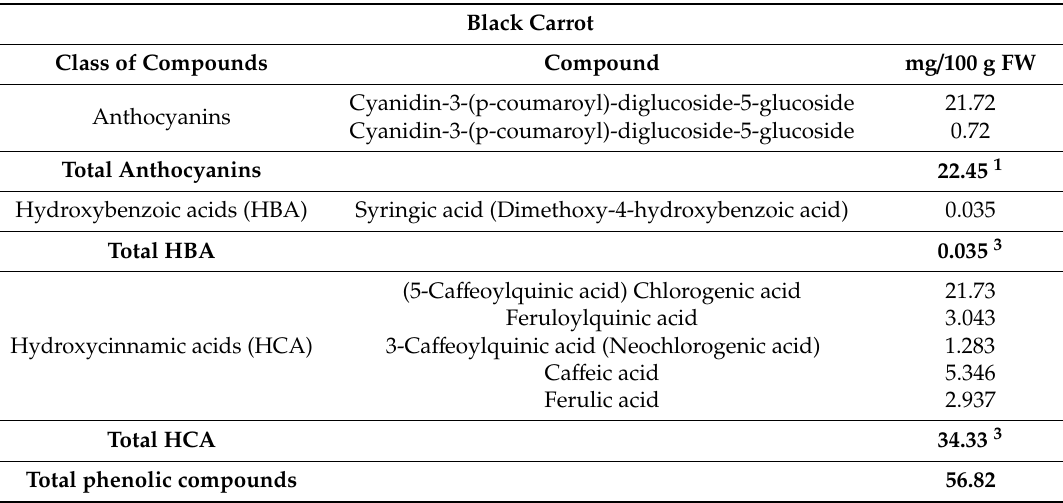
Table 12. Total polyphenolic compounds content in black carrot. Black Carrot